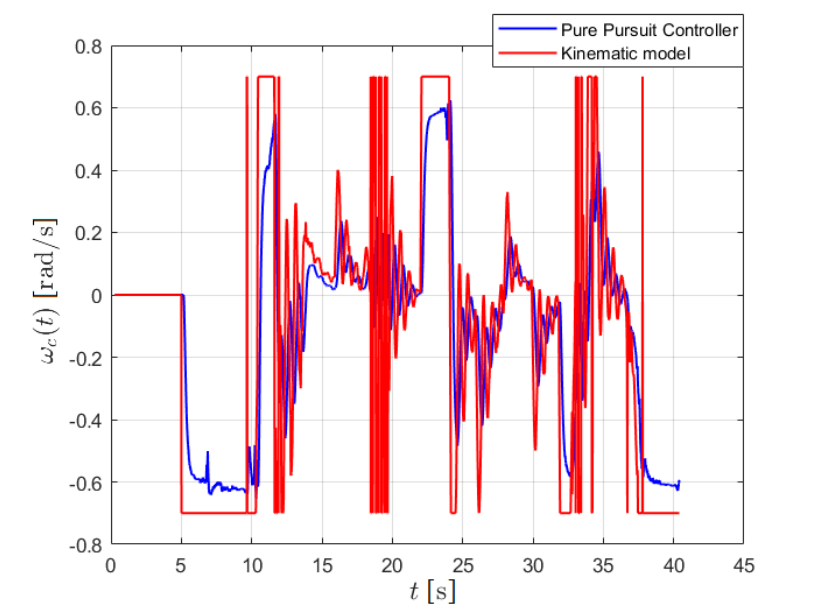
Figure 23. Angular rate ω c ( t ) of the QBot 2e robot.